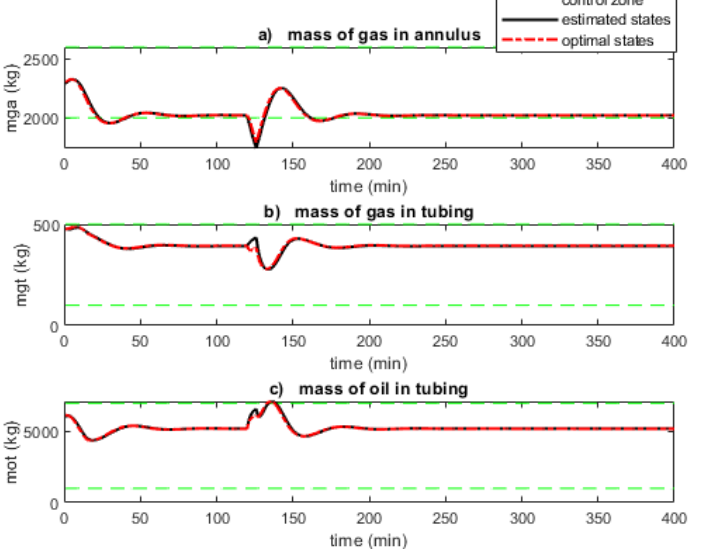
Figure 16. States of the gas-lift system with disturbance occurring between the 120th and 125th minutes. The saturated optimal inputs ensure faster disturbance attenuation than when the input target is within the